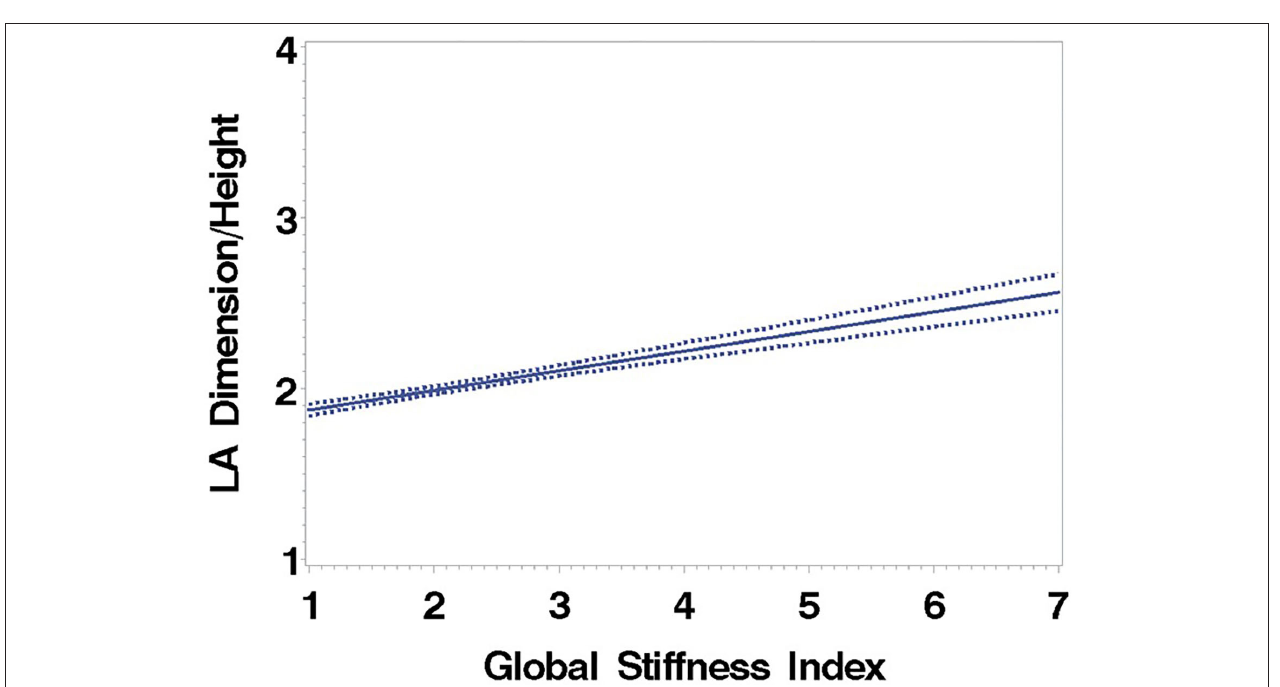
FIGURE 1 | Left atrial dimension/height regressed on the Global Stiffness Index (mean with 95% confidence limit). R 2 = 0.40; P for slope differs from zero < 0.0001 in fully adjusted model.